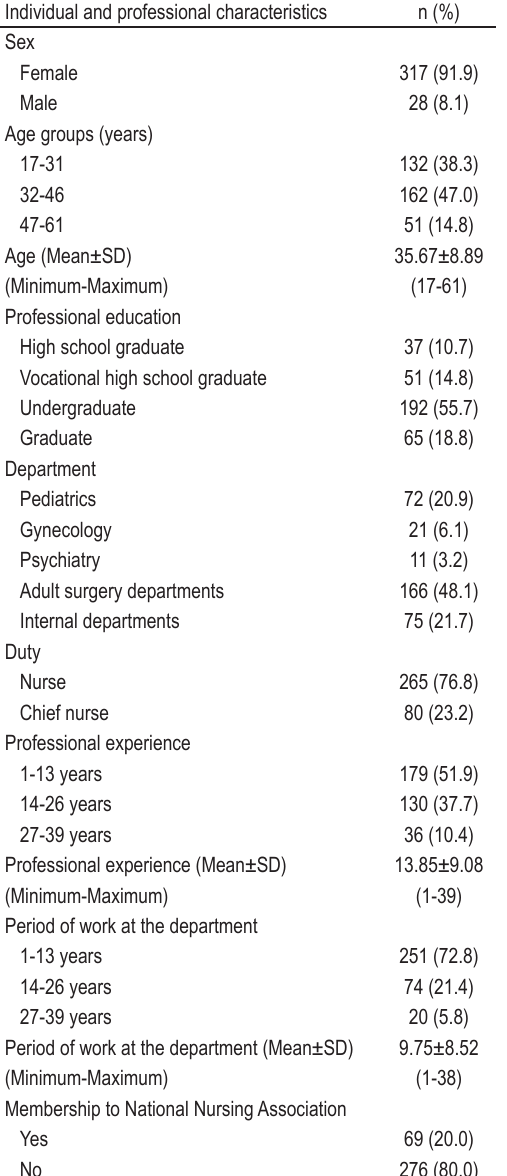
TABLE 1. Nurses’ individual and professional